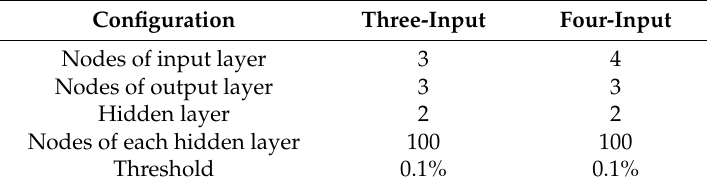
Table 2. DLNN configurations for three-input and four-input